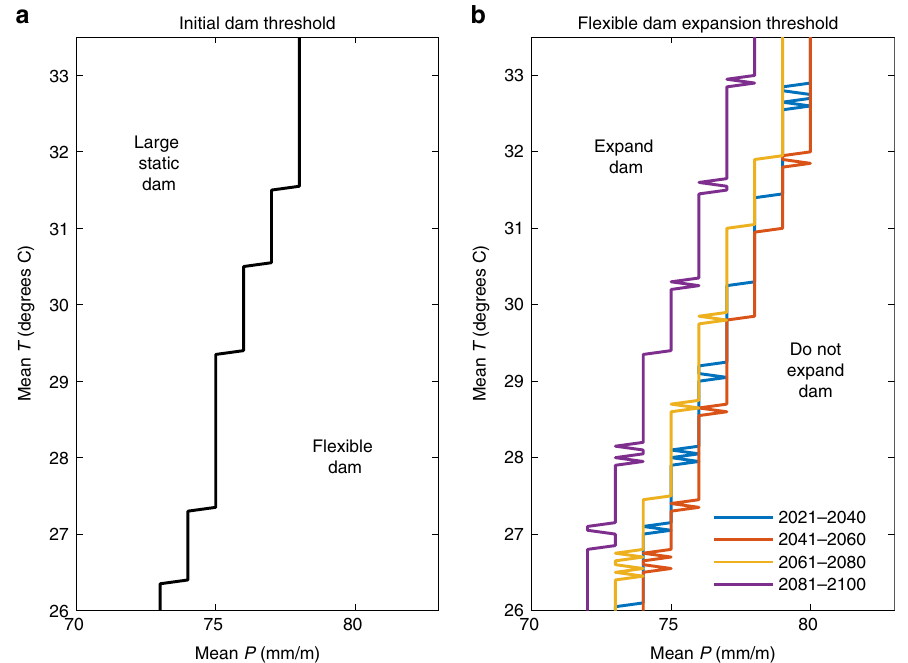
Fig. 4 Optimal policies from SDP. a Threshold for initial decision between large static and fl exible design as a function of T and P during the fi rst time period (2000 – 2020). b Thresholds for exercising the option to increase height of fl exible dam as a function of T and P during the latter time periods as indicated on the legend. Results shown for planning scenario